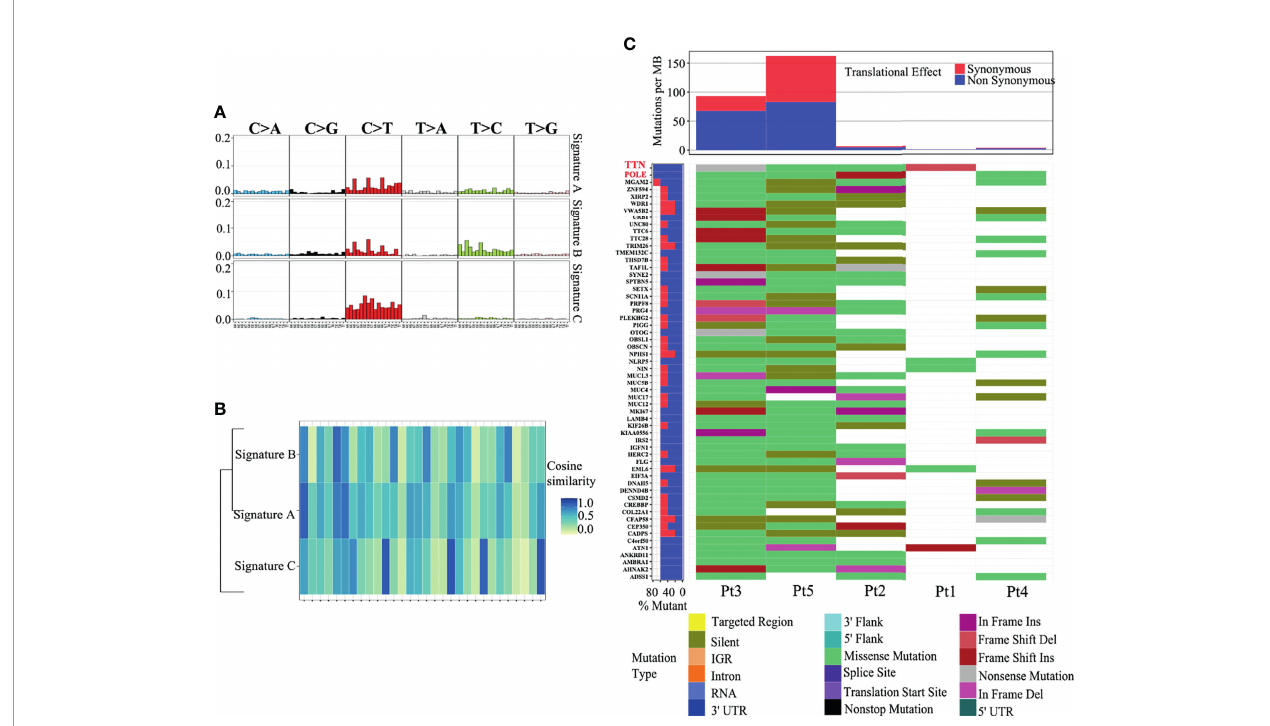
FIGURE 4 | Three mutation signatures in ACSCC matched with the COSMIC database. (A) Nucleotide change in the three mutation signatures. (B) Cosine similarity of the three mutation signatures. (C) SMGs with a somatic mutation frequency ≥ 60% and mutation